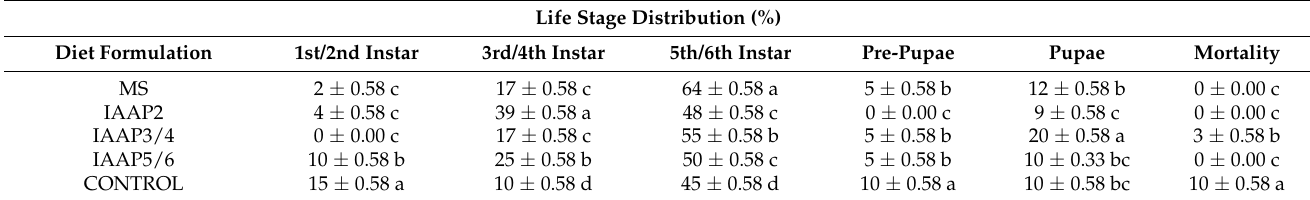
Table 4. Mean ( ± SE) distribution of Eldana saccharina life stages (percentage of the 1st/2nd instar larvae; 3rd/4th instar larvae; 5th/6th instar larvae; pre-pupae; pupae and mortality) [ n = 30] surviving on the MS, IAAP2, IAAP3/4, IAAP5/6 and control diets, 20 days after inoculation. Means within columns with different lower-case letters indicate significant differences ( p < 0.05). Life Stage Distribution (%) Diet Formulation